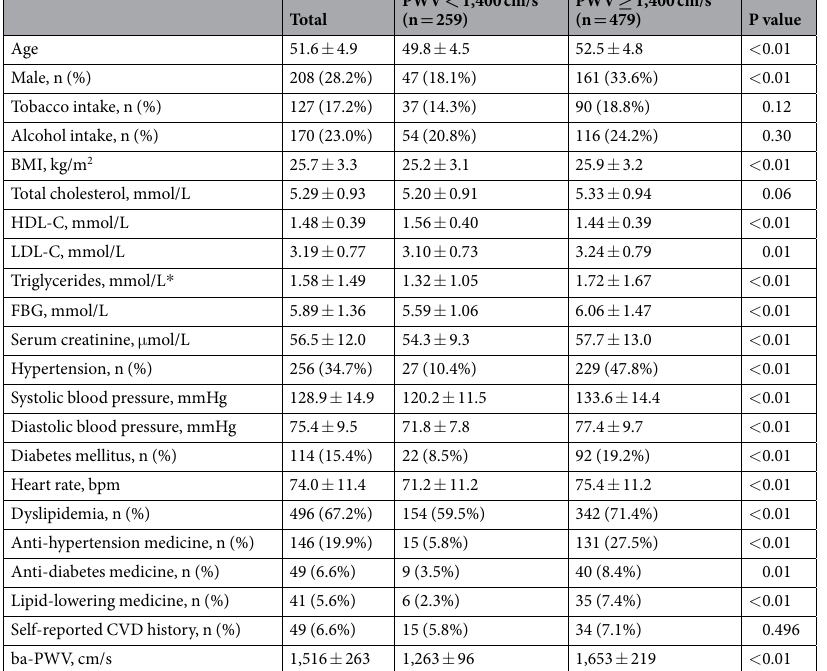
Table 1. Demographic and clinical characteristics at baseline (n = 738). Notes: Abbreviations: BMI indicates body mass index; HDL-C, high-density lipoprotein cholesterol; LDL-C, low-density lipoprotein cholesterol; FBG, fasting blood glucose; CVD, cardiovascular disease. Triglycerides * : Median (Interquartile